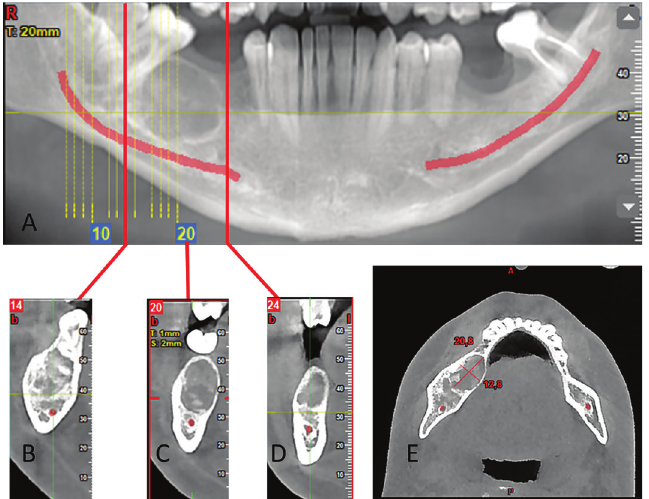
Figure 2 - Panoramic view (A). Cross-Sections on CBCT scans of the tumor (B-D). Axial CT image